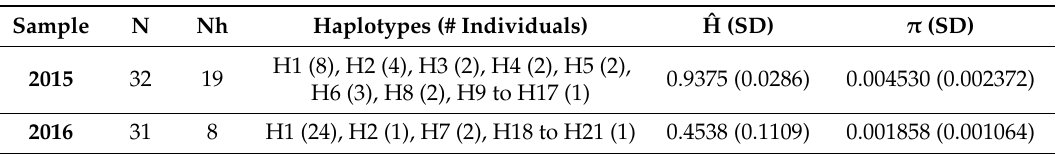
Table 2. Mitochondrial DNA genetic diversity. N—number of individuals; Nh—number of haplotypes; Ĥ—haplotype diversity; π—nucleotide diversity.